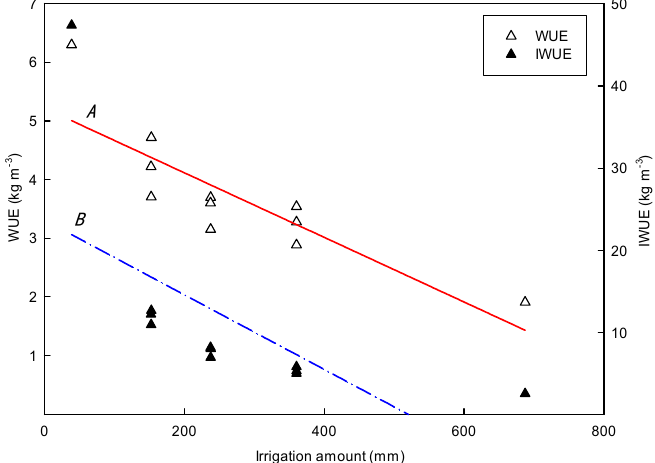
Figure 10. The relationships between irrigation amount and WUE, IWUE. A and B represent changes of WUE, IWUE with irrigation water, respectively. Table 6. Results from two-way ANOVA of the effect of various patterns of RFPS and irrigation levels on yield, WUE and IWUE.